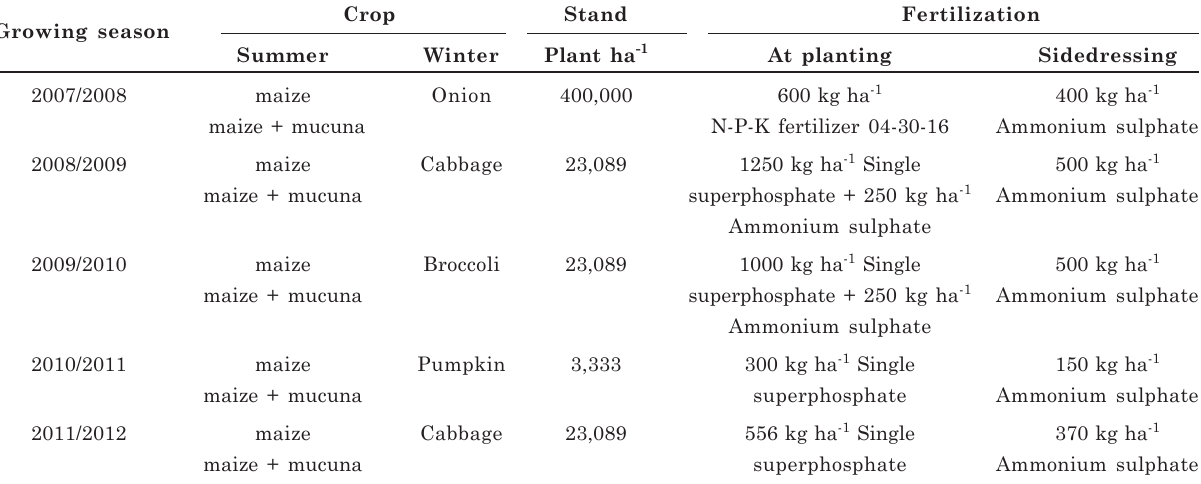
Table 1. History of crops, plant density and fertilization